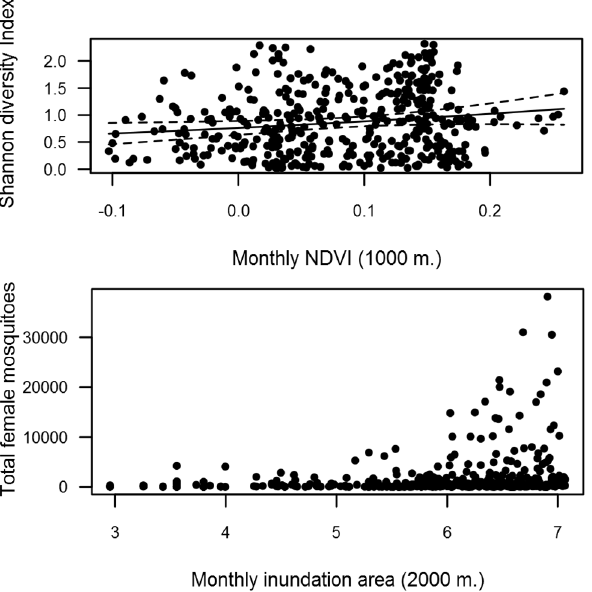
Fig 7. Relationships between Shannon diversity Index and monthly NDVI, and between monthly mosquito abundance and inundation area.